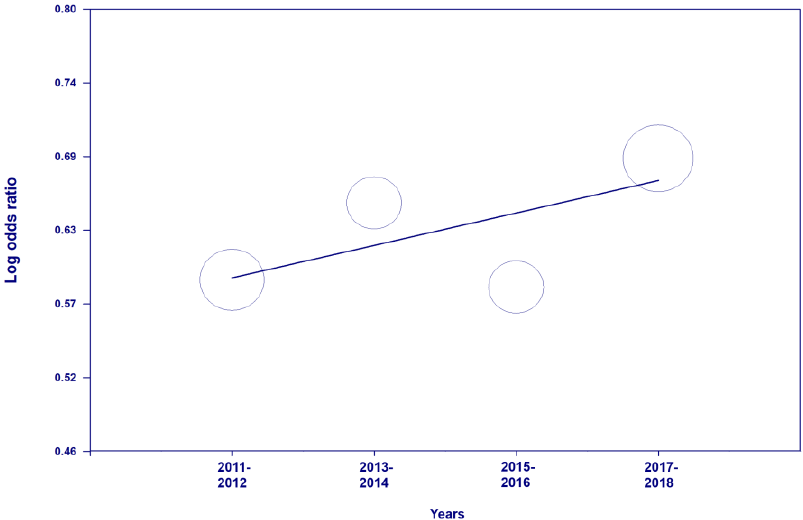
Figure 4. Trend in the association between participating physical education classes and meeting physical activity guidelines across the 4 cycles.